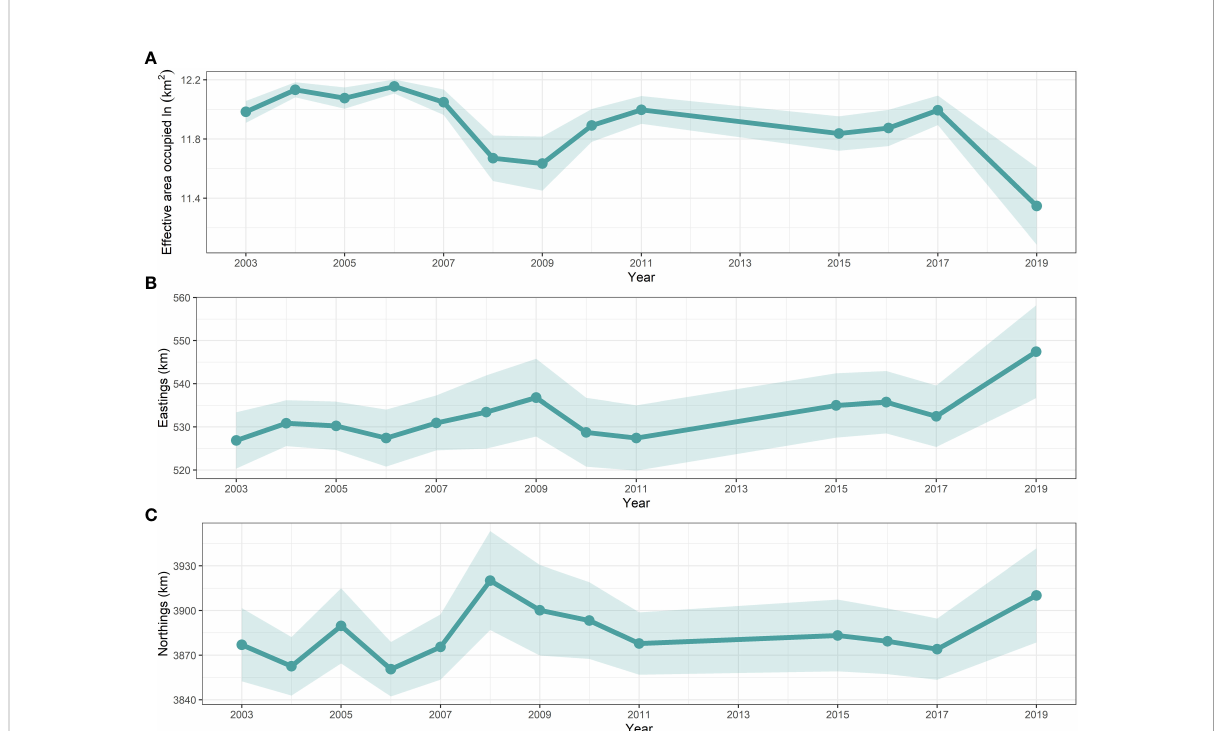
FIGURE 5 Temporal trend with 95% con fi dence intervals (shaded areas) in the effective area occupied (ln(km 2 )) estimated by the AIC-selected spatio- temporal model (M2) for snail fi sh in the Yellow Sea in 2003 – 2019. It is noted that only estimations for those years where biomass trawl